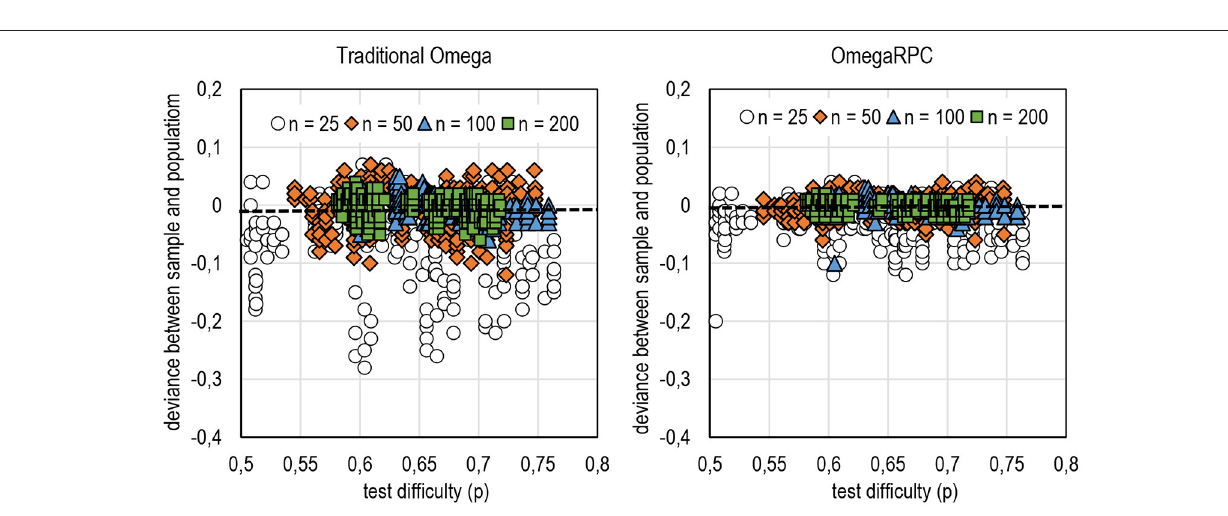
FIGURE 6 | Deviance between sample and population estimates by a DCER based on